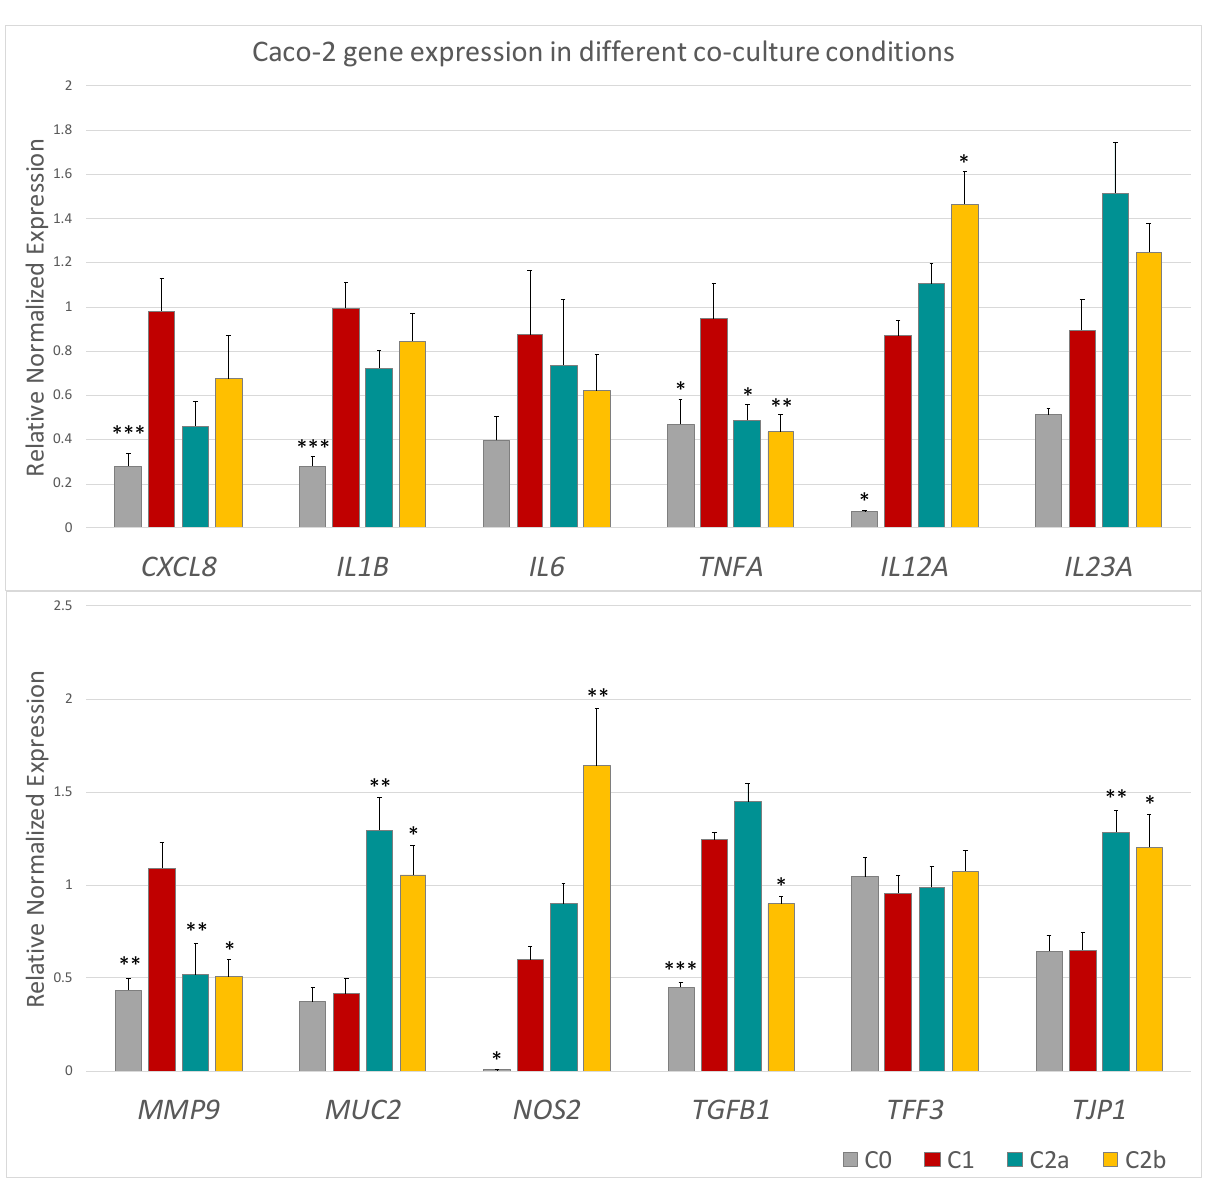
Figure 5. Histogram of Caco-2 tested gene expression in the different culture conditions:co-culture of Caco-2 and THP-1 cells in basal conditions (C0—gray), inflamed co-culture (C1—red), 10 10 mEV administration to Caco-2 cells in inflamed co-culture (C2a—green), and 10 10 mEV administration to Caco-2 and THP-1 cells in inflamed co-culture (C2b—yellow). Differences (others vs C1) were evaluated using the Kruskal–Wallis test and applying the post-doc Dunn’s multiple comparison test. The asterisks indicate the statistical significance: * p < 0.05, ** p < 0.01 and *** p < 0.001.